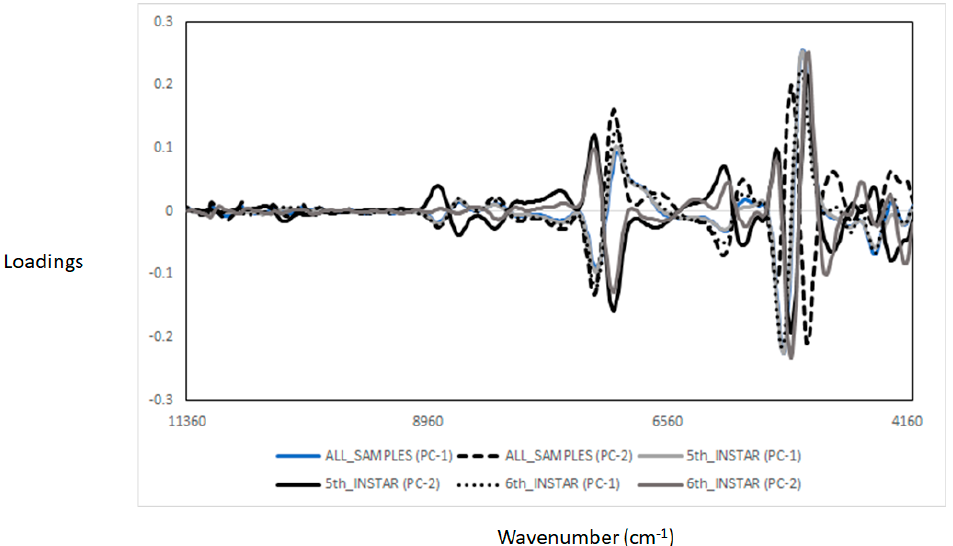
Figure 5. Loadings derived from the principal component analysis from the black soldier fly sam- ples analysed using near infrared reflectance spectroscopy. analysed using near infrared reflectance